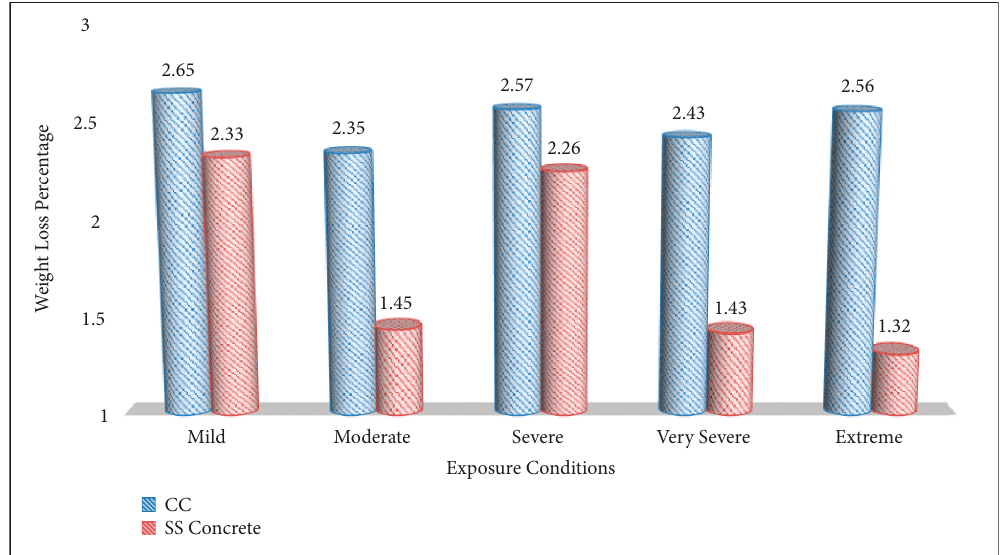
Figure 11: Comparison of weight loss percentage of CC and SS concrete in H